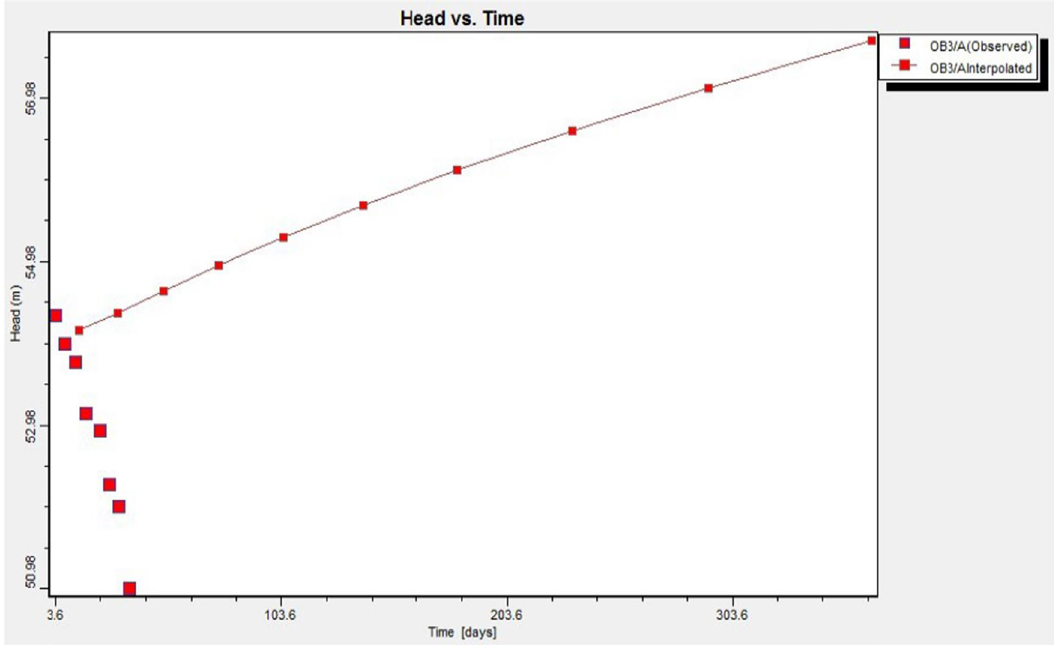
Fig. 9 Head vs. times for